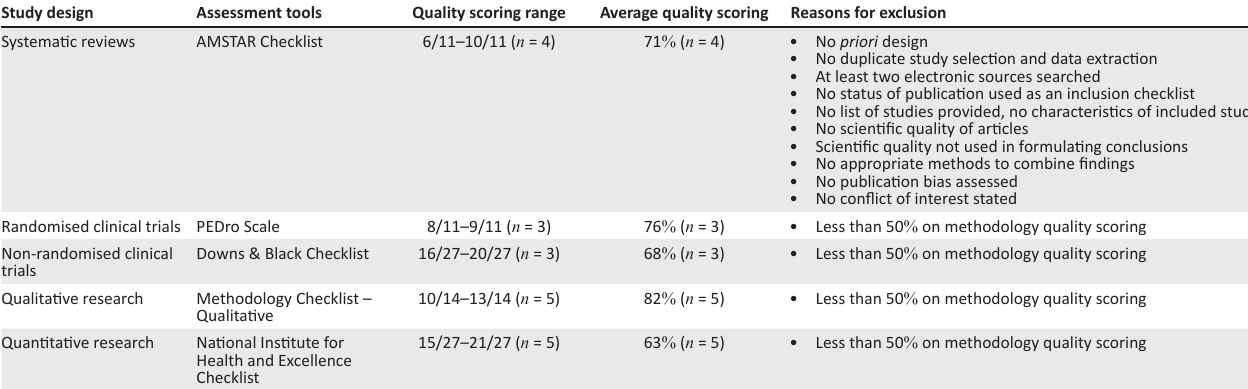
TABLE 1: Methodology assessment tools.